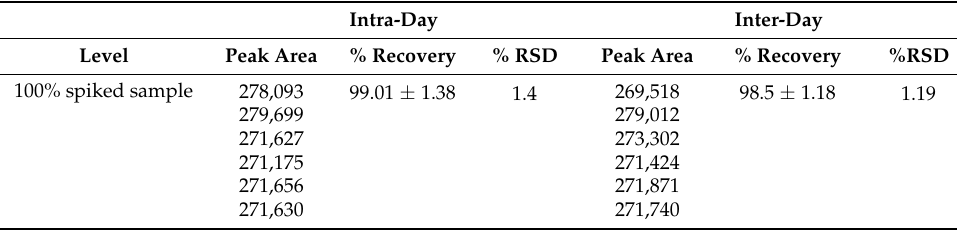
Table 2. Precision and accuracy of paracetamol jelly at intra- and